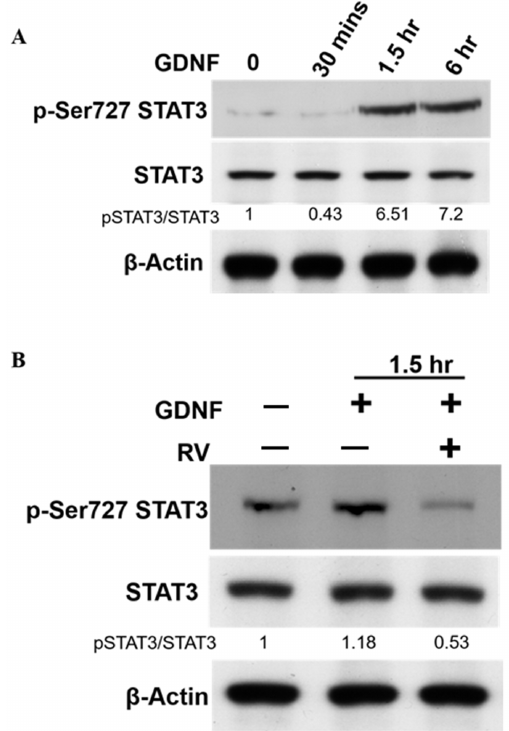
Figure 3. Downregulation of CDK5 inhibits STAT3 activation. ( A ) Protein expression level of pSTAT3 (ser727) and total STAT3 proteins under GDNF treatment for 30 min, 1.5 h and 6 h, respectively. ( B ) Protein expression level of pSTAT3 (ser727) and total STAT3 proteins under the treatment of GDNF, and GDNF + RV for 1.5 h. RV: Roscovitine, a pan CDK inhibitor.